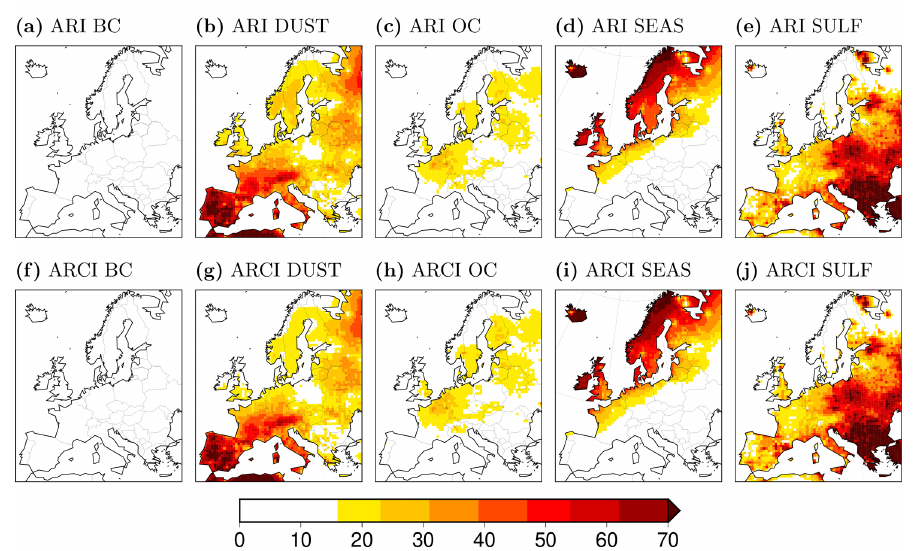
Figure 2. Contribution of each aerosol species (BC: black carbon, DUST and OC: organic carbon, SEAS: sea salt, SULF: sulfate) to the JJA mean total surface aerosol mass concentration in ARI and ARCI simulations in the period 1991–2010. Units: